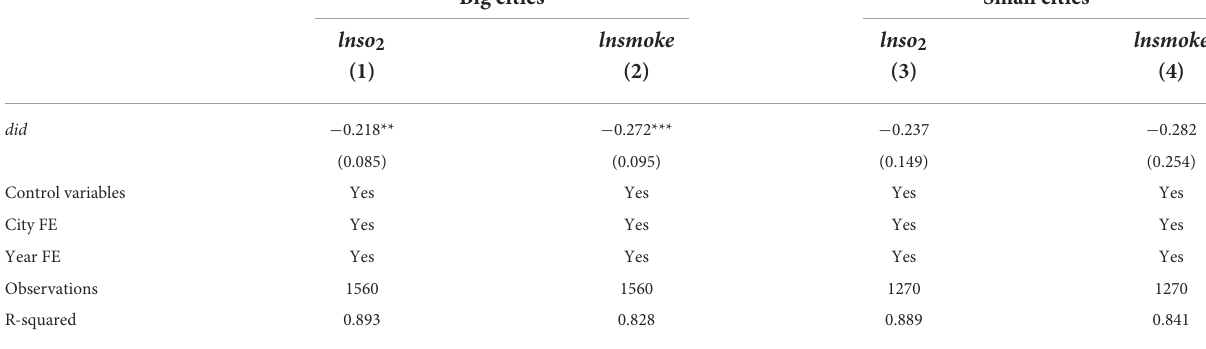
TABLE 7 Heterogeneity analysis of city